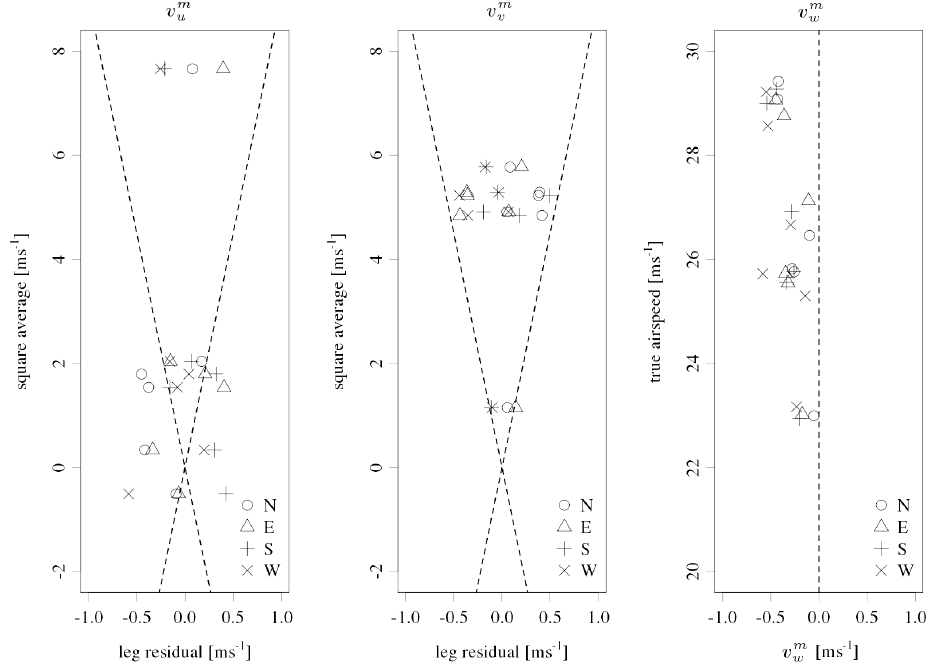
Fig. 11. Results from the wind square flights. For the horizontal wind components ( v m uv ) the x-axis displays the residuals (leg average–square average), while the y-axis shows the wind magnitude. In contrast the vertical wind component ( v m w ) is plotted against the true airspeed. Flight legs are depicted with different symbols according to their position in the square pattern. Dashed lines indicate a 10% criteria for v m uv , and the zero line for v m w .